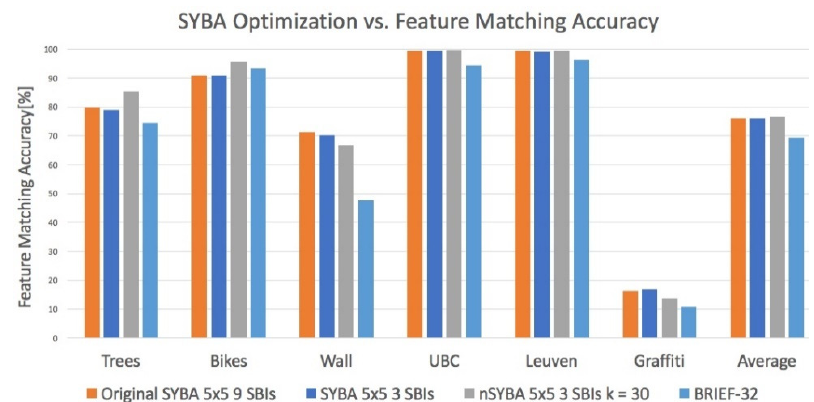
Figure 11. Different SYBA methods and BRIEF-32 vs. feature matching accuracy. Figure 11. Di ff erent SYBA methods and BRIEF-32 vs. feature matching